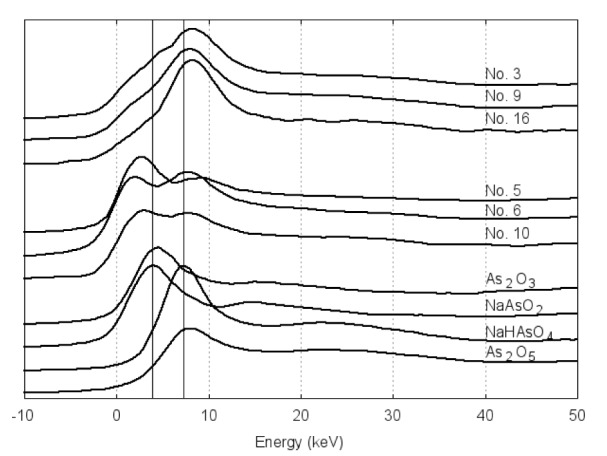
Arsenic speciation in hair samples of residents in an arseniasis hyper-endemic village. Left vertical line: Energy for As3+, right vertical line: Energy for As5+. As2O5, NaHAsO4: References for As5+; NaAsO2, As2O3: Reference for As3+.